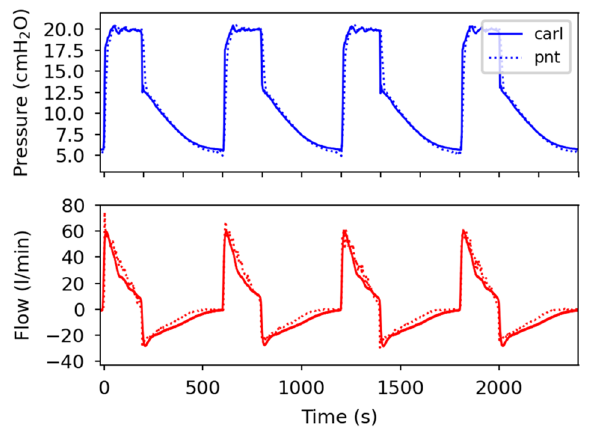
Figure 8. Comparison of measured pressure (blue) and flow (red) data acquired from an external calibrated system ( “pnt”) and CARL (“carl”). All measurements are conducted on an artificial lung and the pressure is generated with the CPAP machine u1 (see Table 3). P IP : 20 cmH2O Respiratory rate: 20 bpm, I:E ratio: 1:2.